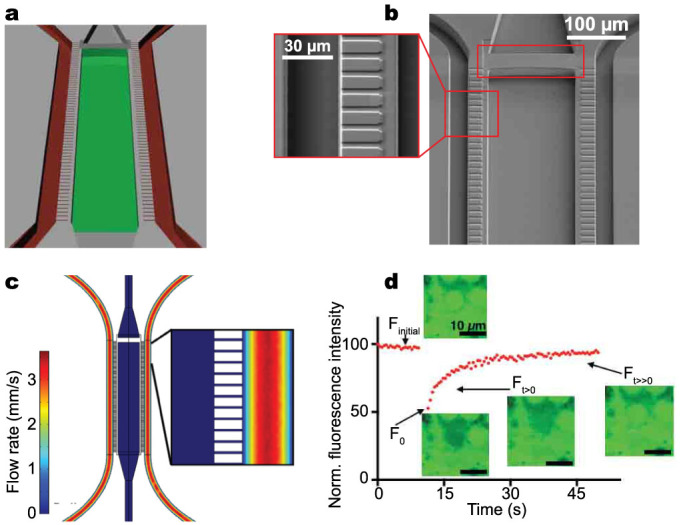
The cardiac microphysiological system (MPS).(a) Schematic of the MPS nutrient channels (red) and cell-loading channel (green). (b) Scanning electron micrograph of the MPS showing in inset the 2 μm endothelial-like barriers connecting the nutrient channel and the cell channel. Red rectangular box shows the weir that enables efficient and consistent loading of singularized high density hiPSC-CMs. (c) Schematic of the cardiac MPS showing nutrient inlet and outlet ports connected to tubes. (d) Simulated velocity profile of flow in the MPS, inset shows the magnified view. Note the lack of convection within the diffusive barriers and predominant convective flow through the nutrient channels. Thus, mass transport to the tissue is exclusively diffusive. (e) Diffusion dynamics in the microphysiological system. Normalized fluorescence recovery of 4 kDa FITC–dextran (0.2 mg/mL). Insets are confocal microscopy images corresponding to the FRAP experiment. Finitial is the time regime that corresponds to the initial fluorescence before bleaching; F0 is the fluorescence measurement immediately after photobleaching; Ft > 0 corresponds to the recovery of fluorescence after photobleaching; Ft ≫ 0 corresponds to maximal recovery of fluorescence at the end of the experiment. Scale bar: 10 μm.